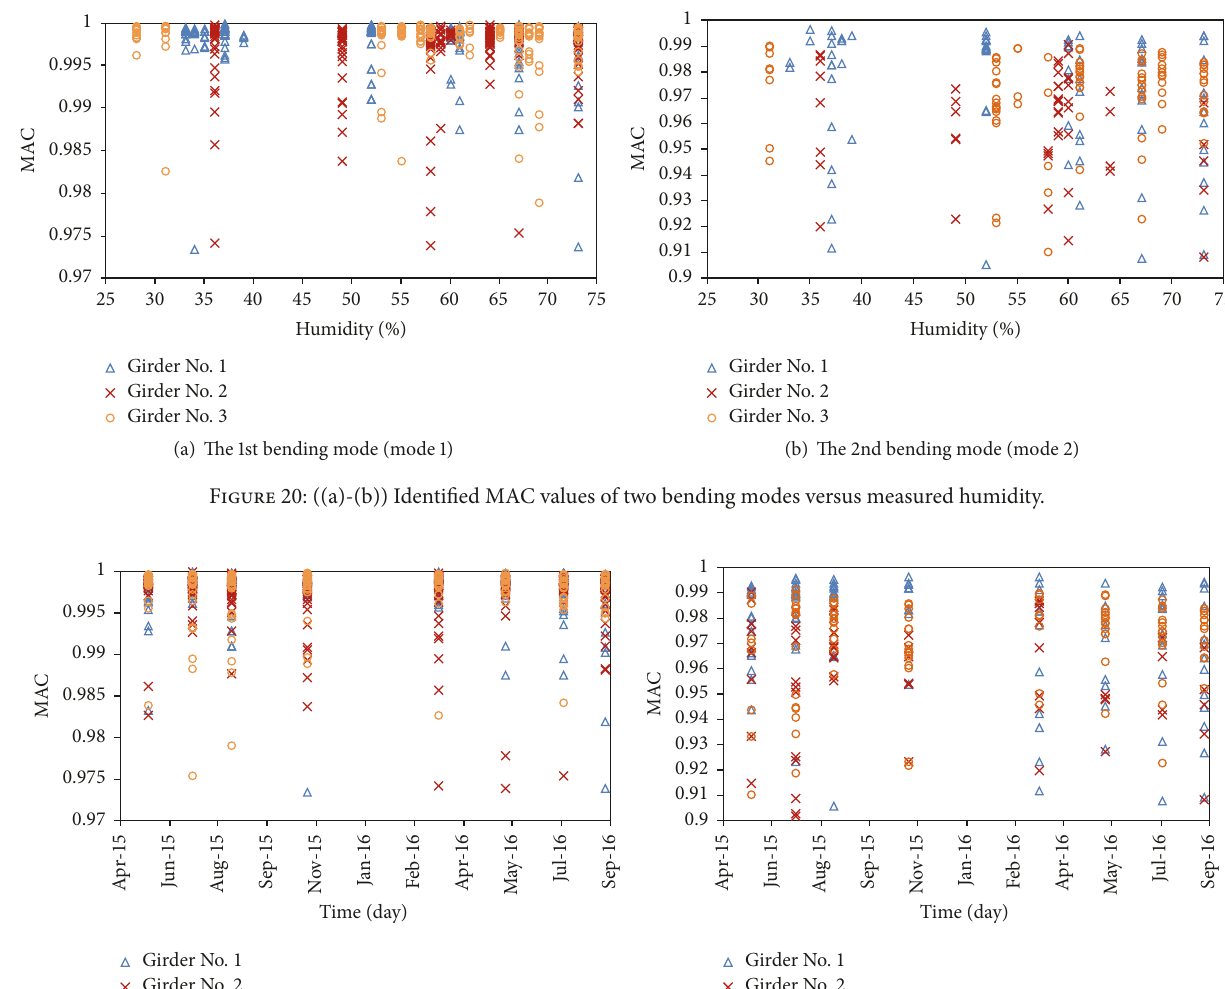
Girder No. 1 Girder No. 2